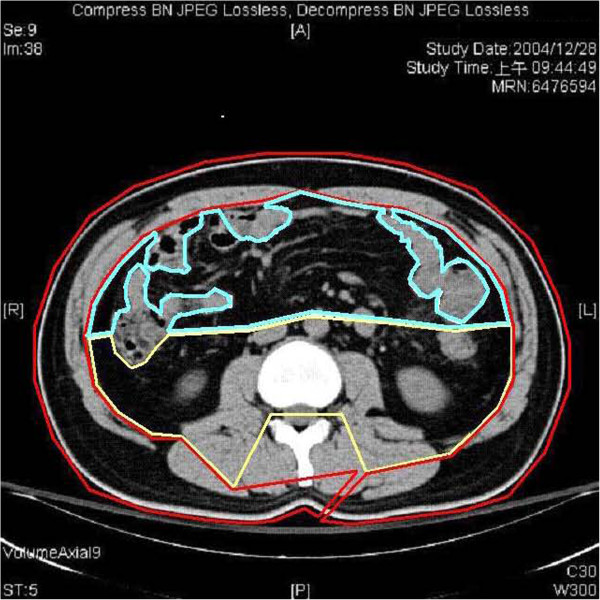
The CT of abdomen shows measurement of intra-peritoneal fat (blue line), retro-peritoneal fat (yellow line) and subcutaneous fat (red line).